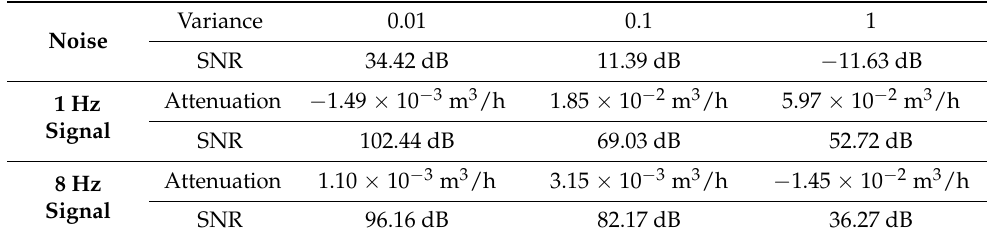
Table 4. Amplitude attenuation and SNR improvement for extracted signals.